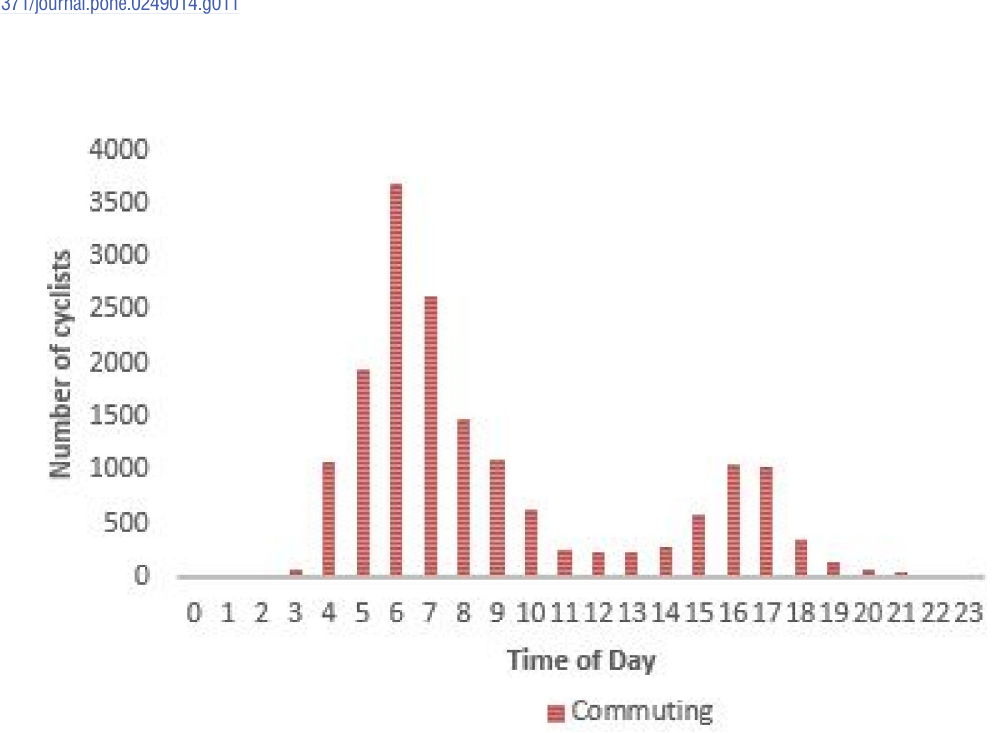
Fig 12. Visualisation of cycling trends based on time of the day.